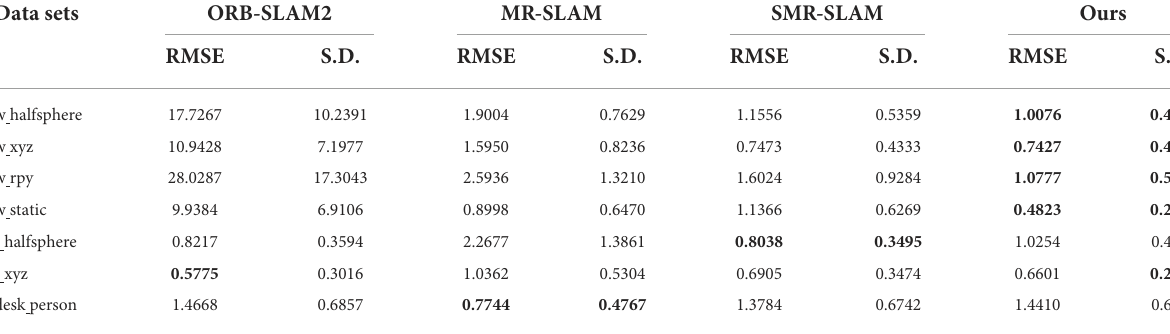
TABLE 4 Rotational drift (RPE) in m/s for the experiments using ORB-SLAM2, MR-SLAM, SMR-SLAM, and Ours. Data